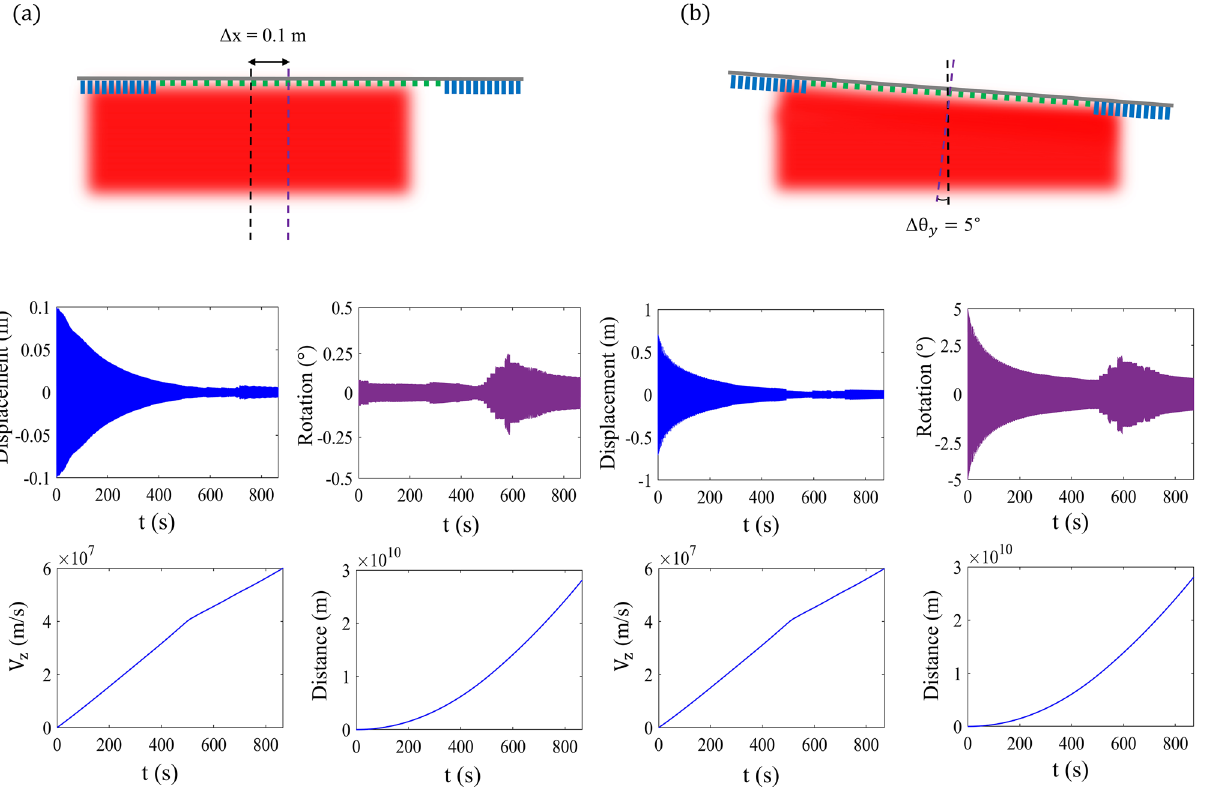
2 m 2 dual-pattern ×